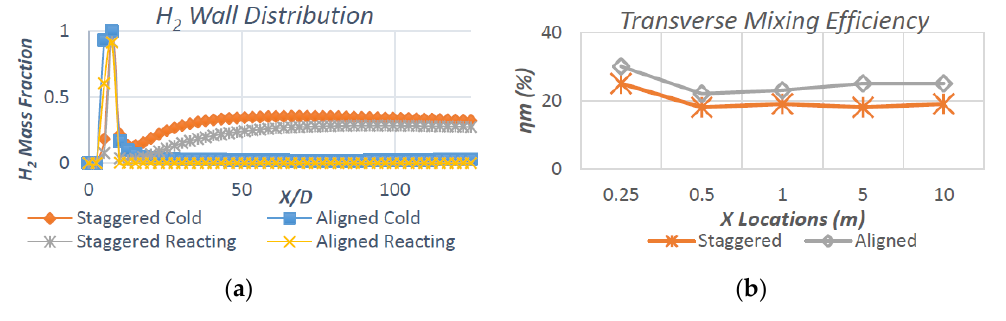
Figure 20. ( a ) H 2 wall distribution; ( b ) Transverse mixing efficiency.